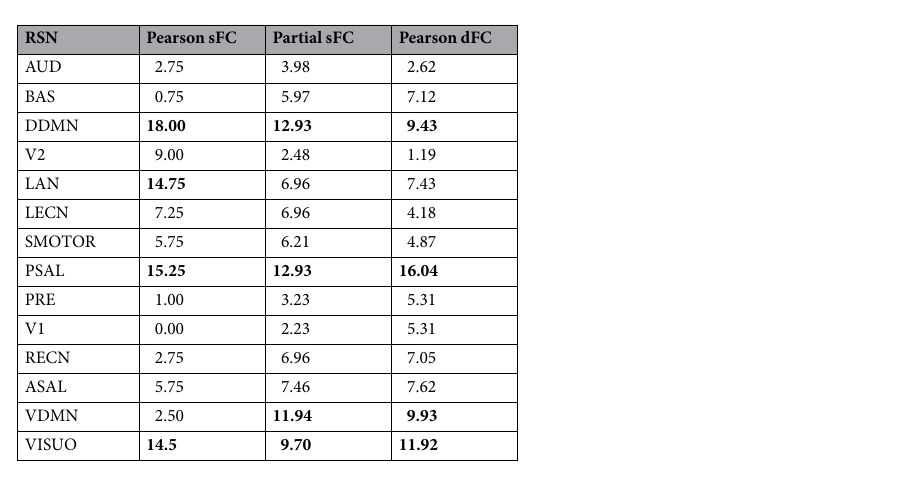
Table 3. RSN contribution percentages based on differential power at 95% threshold in subject identification (top four contributing networks highlighted in bold font). AUD-Auditory, BAS-Basal Ganglia, DDMN- Dorsal Default Mode Network, V2-Primary Visual, LAN-Language, LECN-Left Executive Control Network, SMOTOR-Sensorimotor, PSAL-Posterior Salience, PRE-Precuneus, V1-High Visual, RECN-Right Executive Control Network, ASAL-Anterior Salience, VDMN-Ventral Default Mode Network,